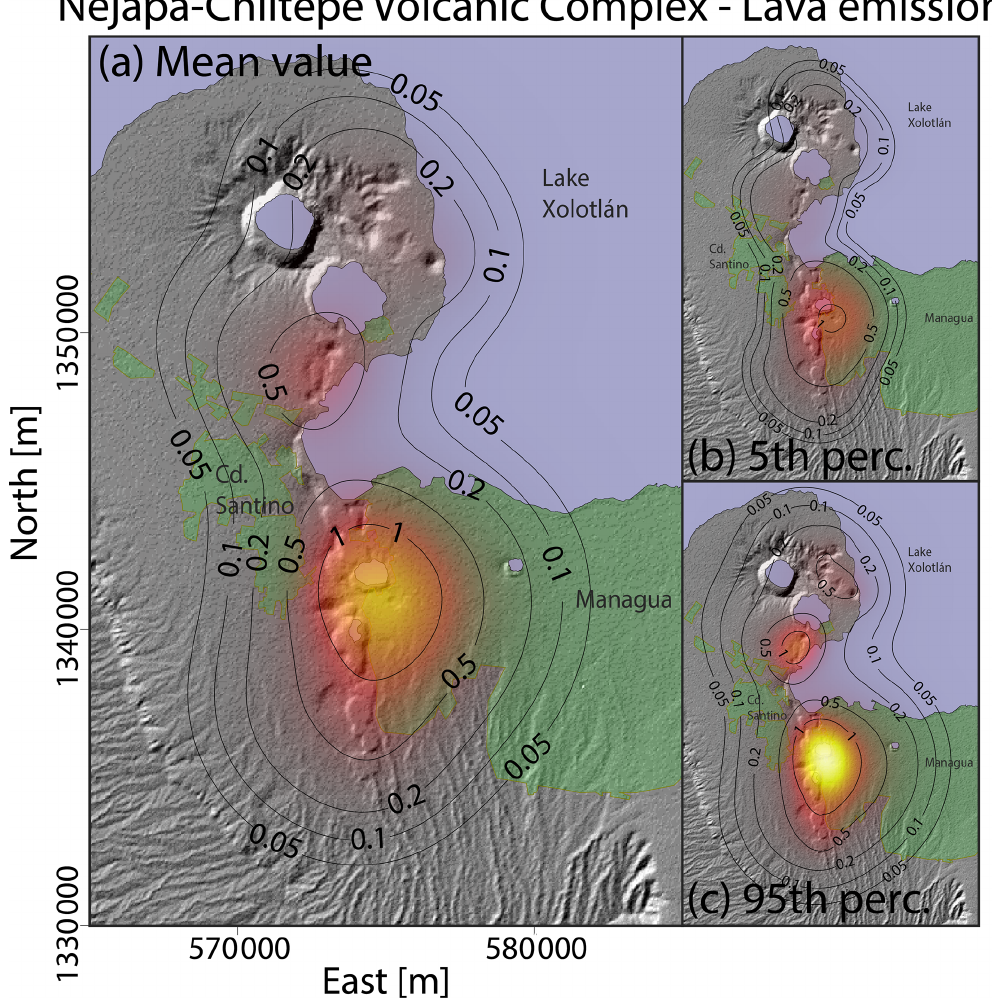
Figure 6. Density distribution of the probability of vent opening at the Nejapa-Chiltepe volcanic complex associated with the occurrence of volcanic activity able to produce lava flows. (a) Mean value. (b) 5th percentile. (c) 95th percentile. Results are expressed in percentage per km 2